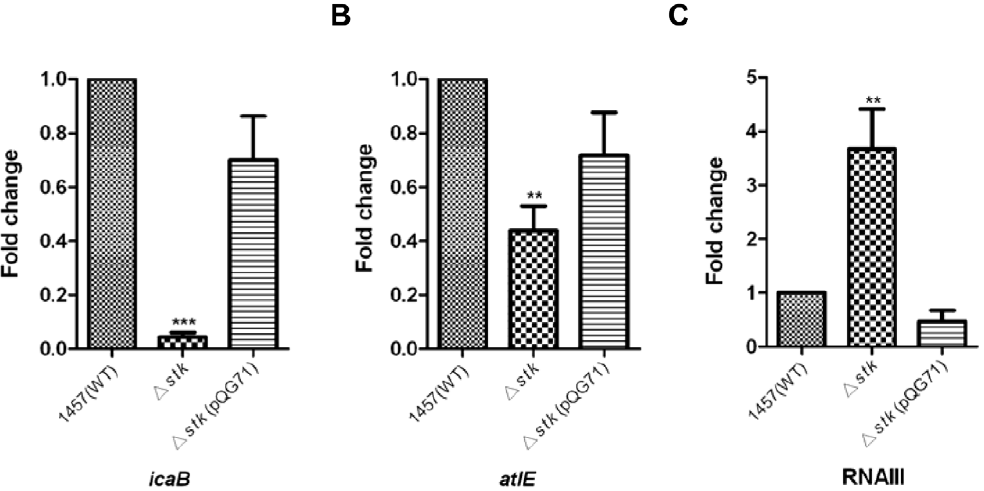
Figure 5. Influence of Stk on the expression of the biofilm-associated genes. The stk mutant strain was complemented with plasmids expressing Stk full length (pQG71) and expression of the icaB (to monitor expression of the icaADBC operon), RNAIII and atlE genes was determined in samples prepared from exponential-phase (OD 600 =0.5) cells grown in BM, using quantitative RT-PCR. Data were derived from three biological repeats. **, P , 0.01; ***, P , 0.001(versus WT).